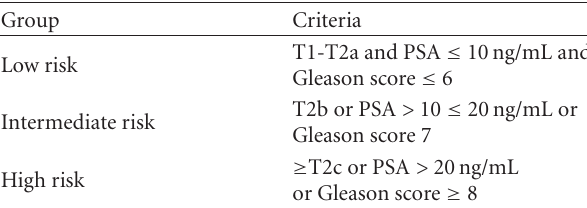
Table 1: Prostate cancer risk